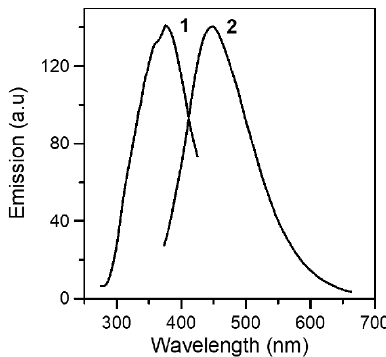
Figure 7. Solid-state, room-temperature excitation (curve 1; maximum emission at 452 nm) and emission (curve 2; maximum excitation at 375 nm) spectra of complex [ZnCl 2 (L)] ( 1 ).